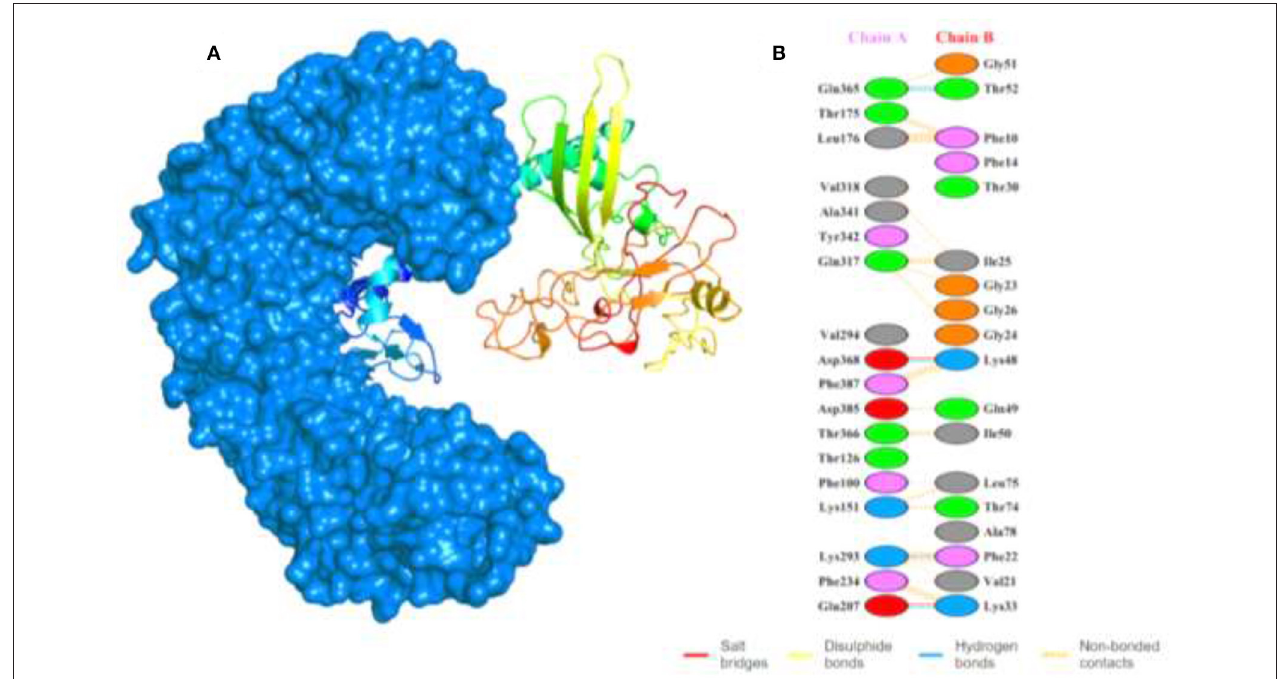
FIGURE 4 | Shows the docking complex of the vaccine structure and human TLR-5. (A) The docking complex with human TLR-5 structure represented in surface view (marine blue color), while the multi-colored attached structure represents the designed MEVC. (B) The binding patterns formed in the docking complex between the two interacting